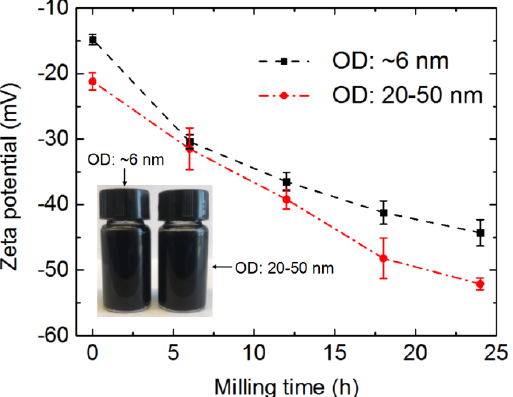
Figure 4. Zeta potentials of two kinds of MWCNTs plotted against ball milling time. Insert photo shows suspensions of two kinds of ultra-short CNTs, which were prepared by 24 h ball milling treatment and acid pickling. These two suspensions were left standing for 100 days.